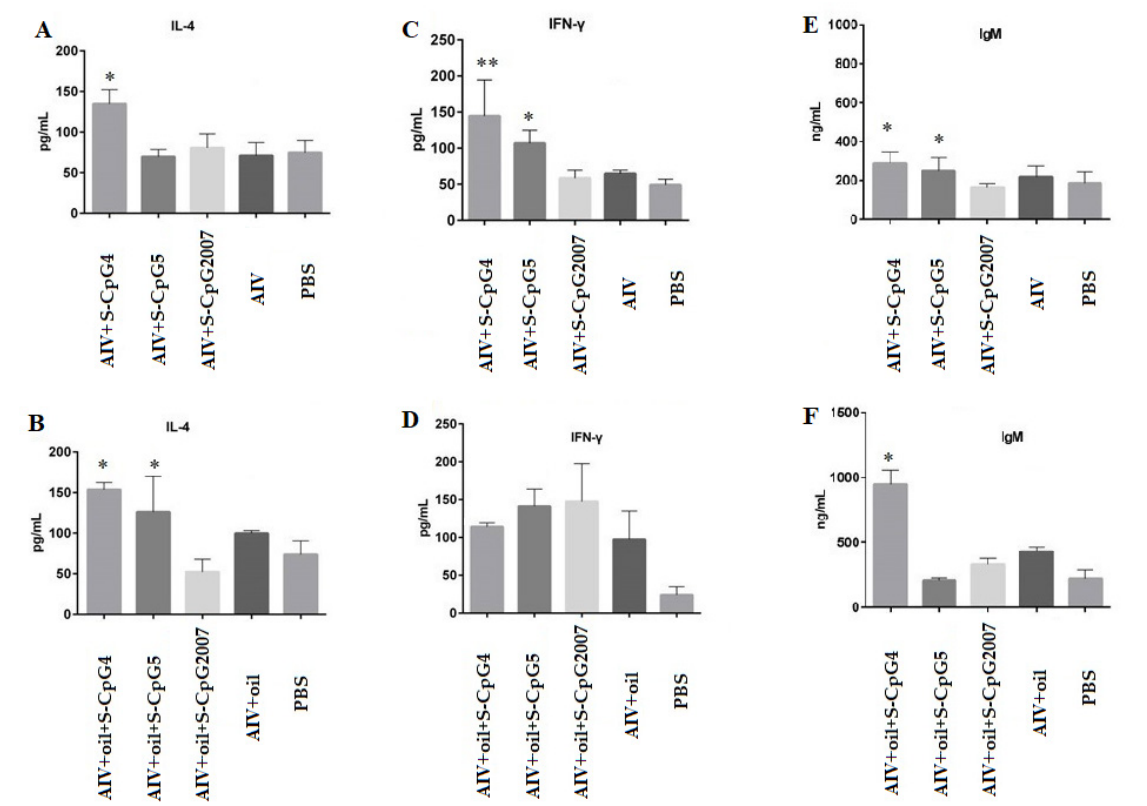
Figure 6. Expression levels of IL-4, IFN- γ , and IgM secreted by splenic lymphocytes. The expressions of IL-2 ( A ), IFN- γ ( C ) and IgM ( E ) of splenic lymphocytes from immunized with S-CpG4, 5 and S-CpG2007 and AIV antigen were detected with qPCR, and expressions of IL-2 ( B ), IFN- γ ( D ) and IgM ( F ) from immunized with S-CpG4, 5 and S-CpG2007 and AIV antigen with oil adjuvantt were measured with qPCR. All data were presented as mean ± SD. * p < 0.05, ** p < 0.01.